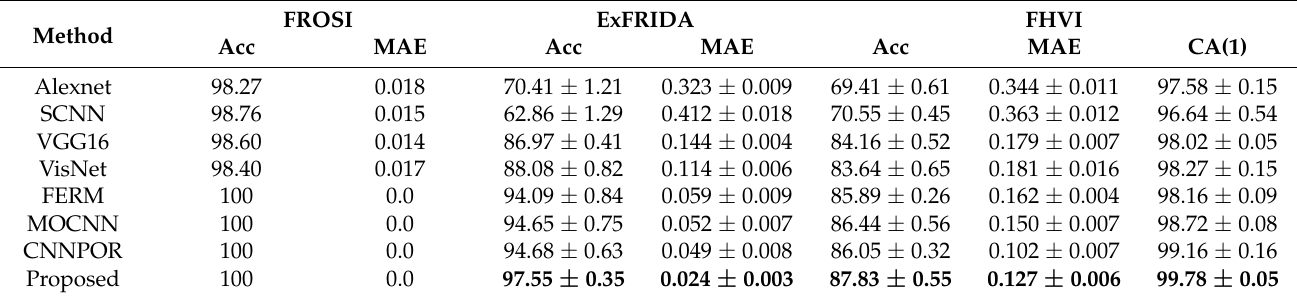
Table 4. Experimental results of different deep-learning methods with three